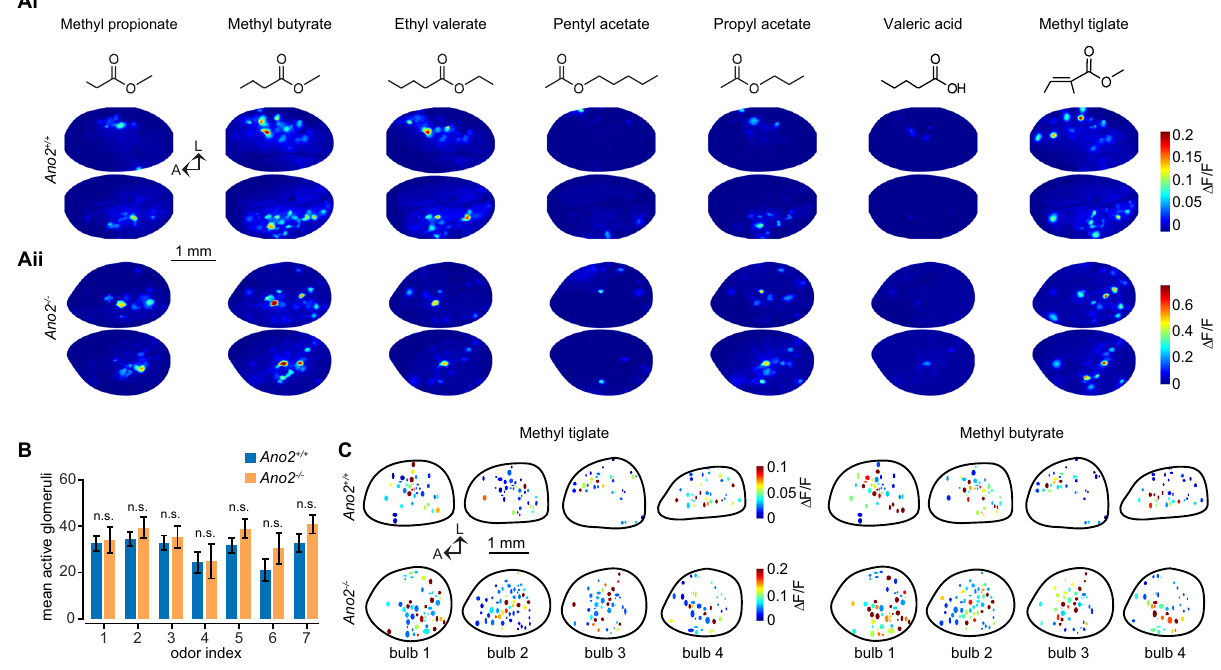
Figure 1. Functional maps of ORN activity. Ai-Aii . Example functional maps for seven unique odors in a representative Ano2 + / + (top) and Ano2 − / − (bottom) animal. Molecular structures of the odors in the panel are depicted above. ( B) Number of glomeruli per bulb (n = 11 Ano2 + / + bulbs, n = 5 Ano2 − / − bulbs) responding to each of the seven odors above ROC threshold (threshold = 0.005 Δ F/F; p > 0.05, Wilcoxon rank-sum test with Bonferroni multiple comparison correction). ( C) Example functional maps from four Ano2 + / + and Ano2 − / − bulbs each for two different, but related odors. Glomeruli are represented as pseudocolored ellipses. The position of each ellipse reflects the location of a glomerulus within one olfactory bulb hemisphere. The black line designates the boundary of the imaged region of each olfactory